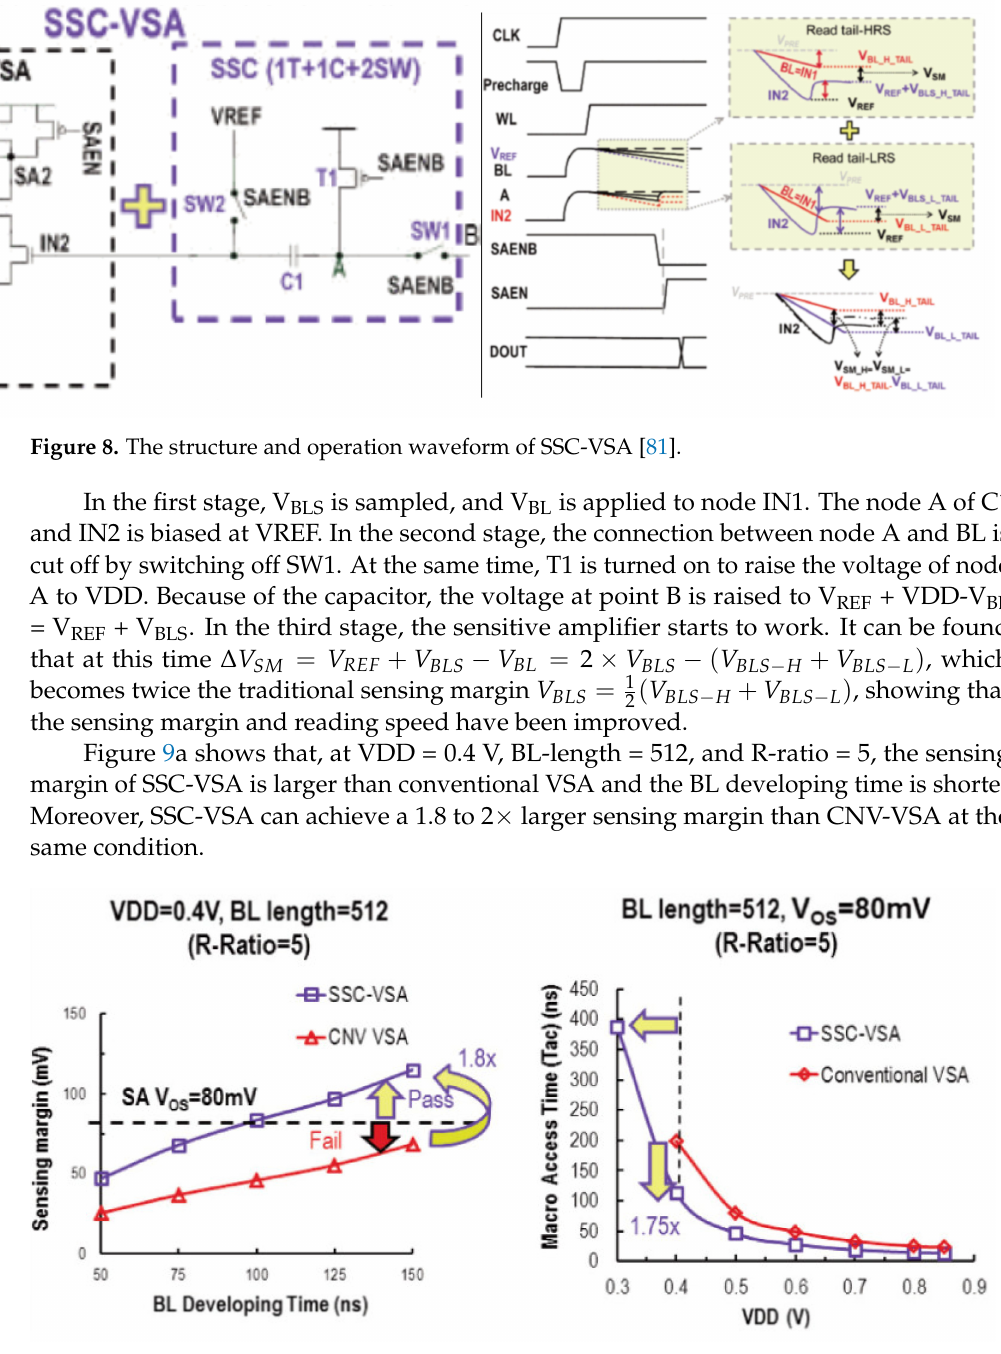
Figure 9. The performance of SSC-VSA ( a ) the sensing margin of SSC-VSA and CNV VSA at different BL developing time ( b ) the macro access time of SSC-VSA and conventional VSA at different VDD